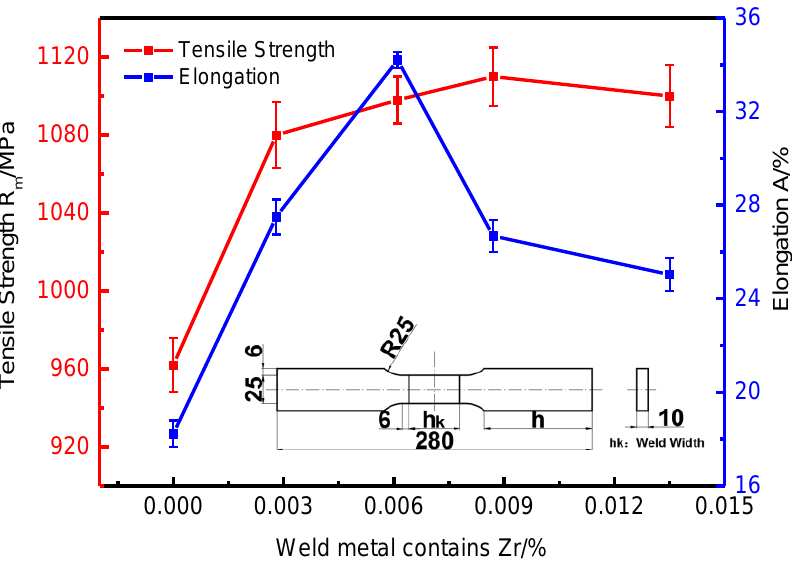
ff ect of zirconium content on tensile strength and elongation of welded Figure 11. Effect of zirconium content on tensile strength and elongation of welded joints. Figure 11. E